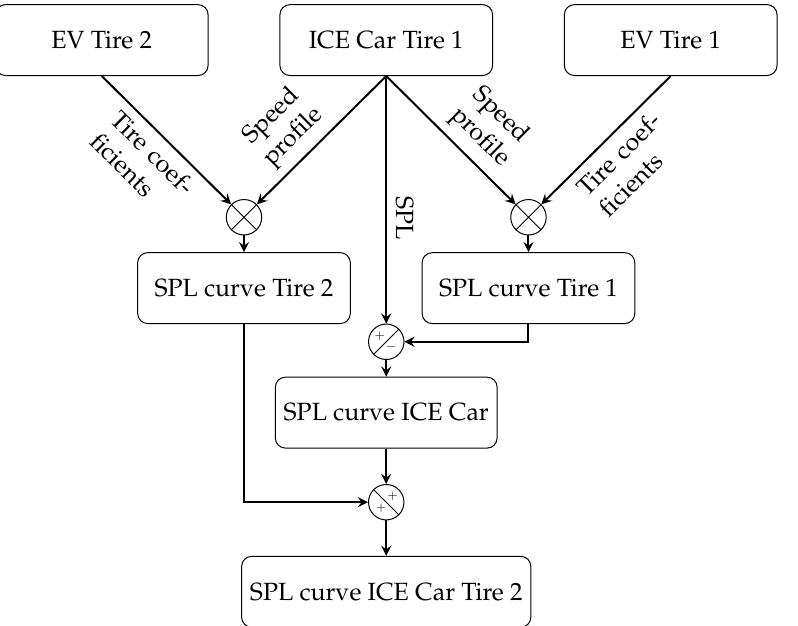
Figure 17. Principal sketch of tire changing algorithm.